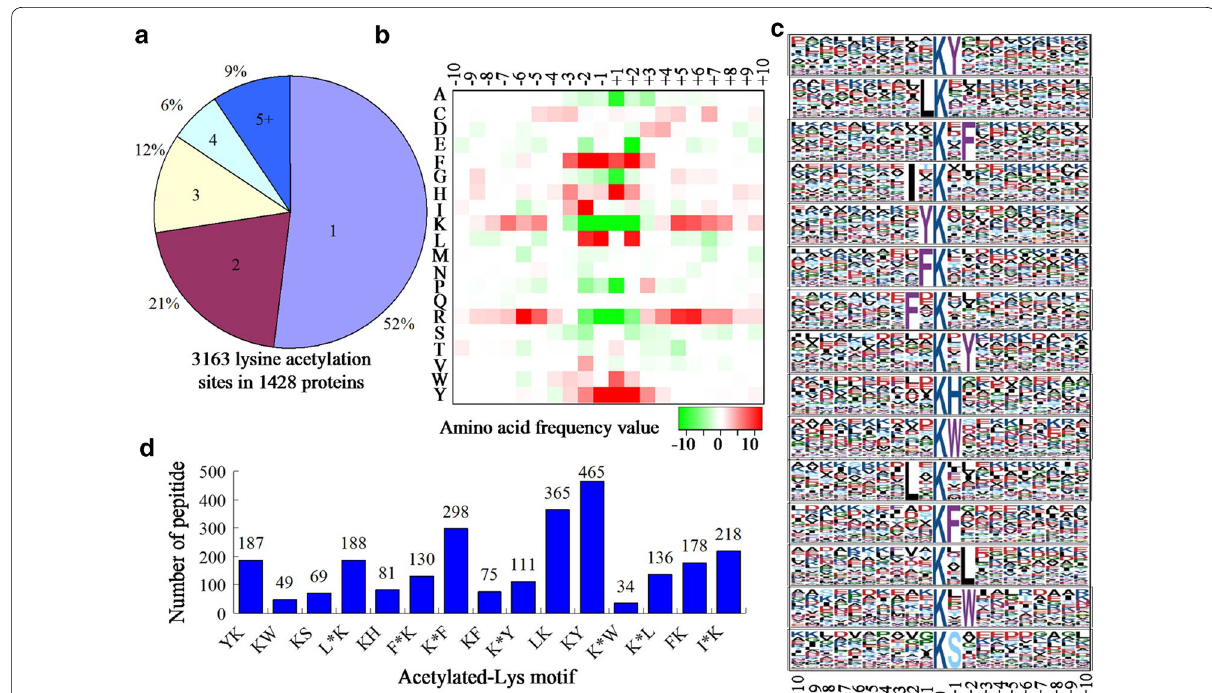
Fig. 4 Distribution and motif analysis of lysine acetylation sites. a Pie chart illustrating the number and percentage of lysine acetylation sites per protein. b Heat map of the amino acid compositions around the lysine acetylation sites showing the frequency of different types of amino acids surrounding this residue. c Sequence probability logos of significantly enriched acetylation site motifs for lation sites. d Number of identified peptides contained in each conserved